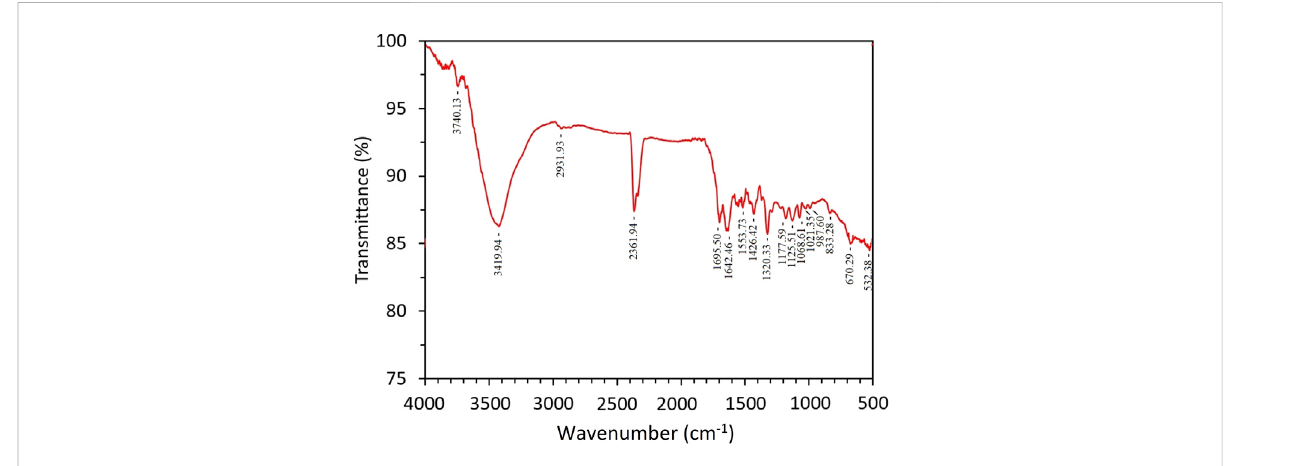
FIGURE 2 Fourier transform spectra of AgNP synthesized with Rhodiola rosea.